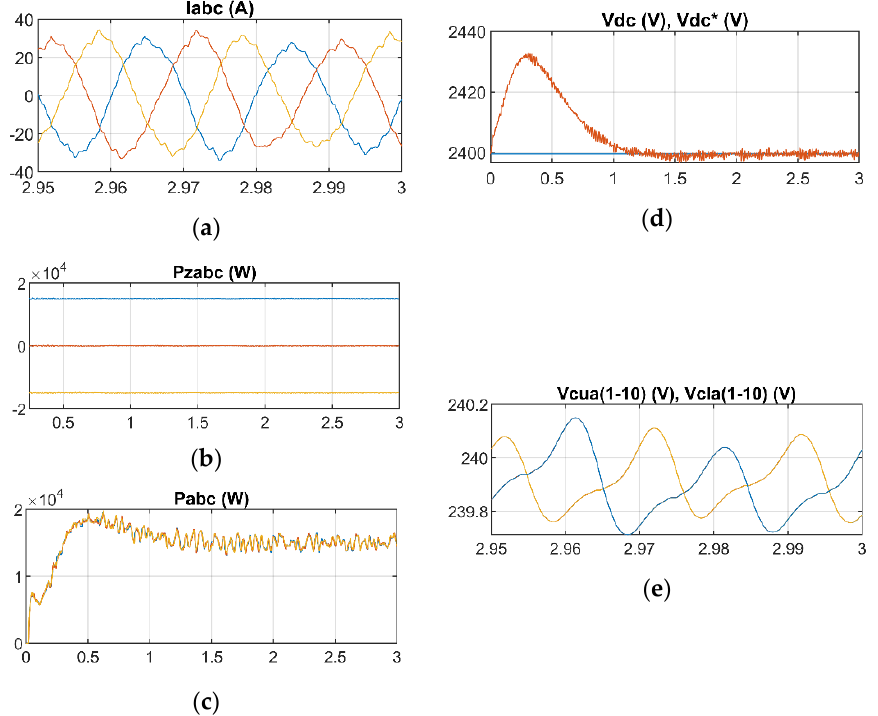
Figure 10. Simulation graphs when the generation has a large imbalance between phases. ( a ) Output currents. ( b ) Power transferred between phases. ( c ) Power delivered by each phase. ( d ) Voltage on the DC link. ( e ) Capacitor voltages.